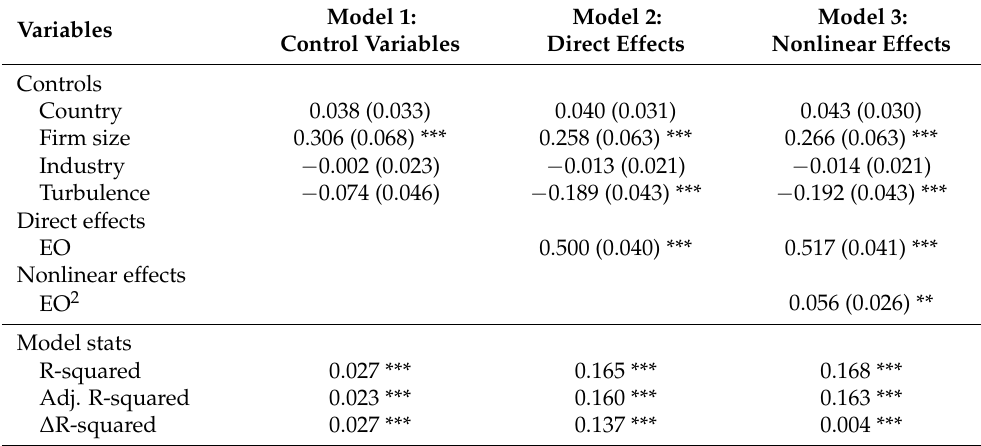
Table 2. Results of hierarchical regression analysis for financial firm performance (n = 963).